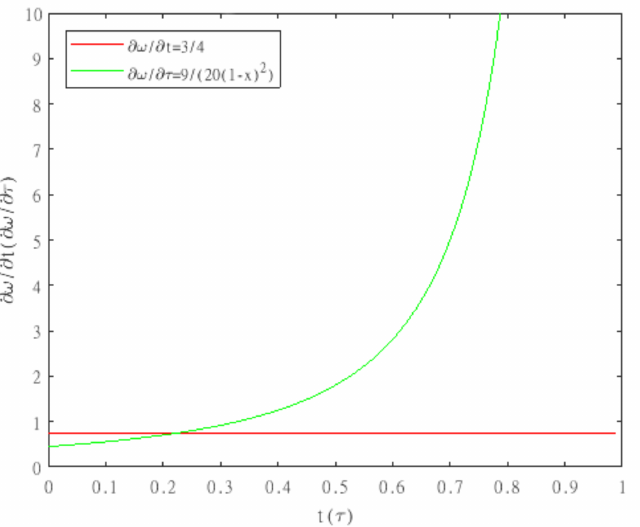
Figure 7. Price change rate for the intermediate product of firms in the upstream country in response to changes in the ad valorem tax and specific duty.